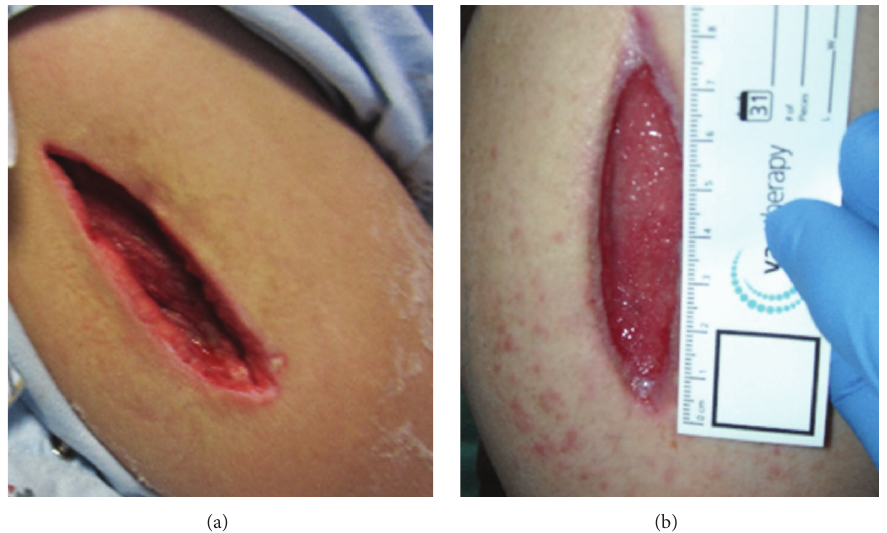
Figure 1: Right upper extremity 10 (a) and 54 (b) day after surgical